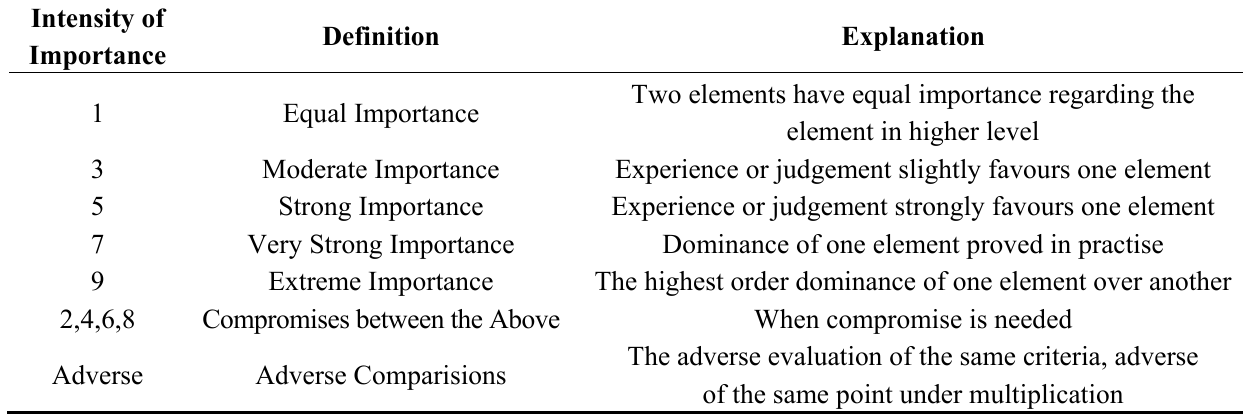
Table A1. Evaluation Scale in